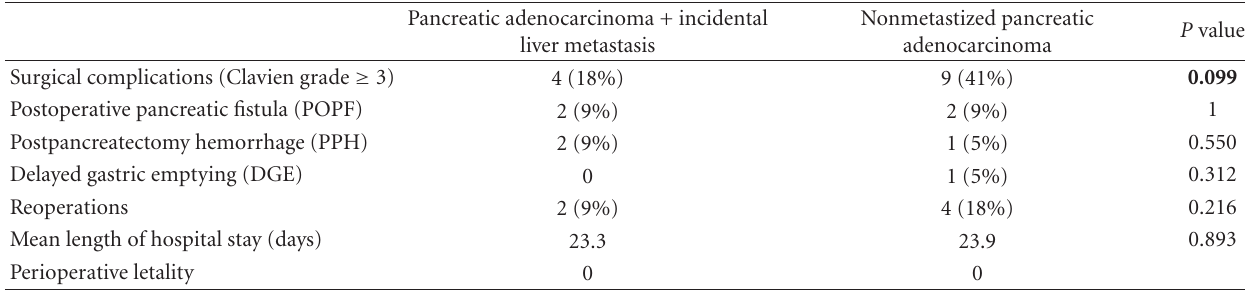
Table 3: Postoperative